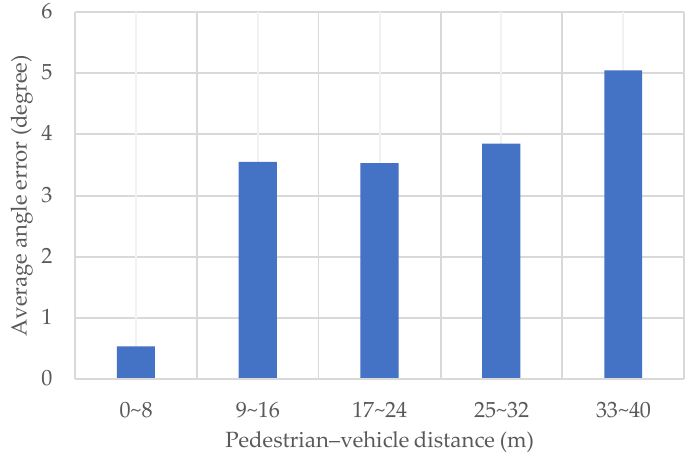
Figure 11. Average angle error for each pedestrian–vehicle distance.